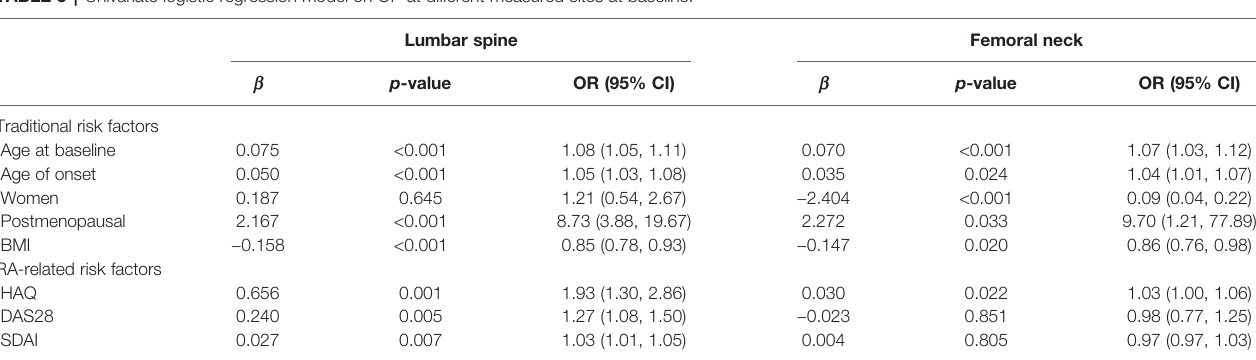
TABLE 3 | Univariate logistic regression model on OP at different measured sites at baseline.